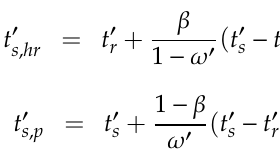
Figure 4. Variation of the design supply water temperature of the PB ( 𝑡 (cid:3046),(cid:3043), ) with different network temperature levels, base load ratio ( β ) and design peak shaving flow ratio ( ω ’ ) for series connection.